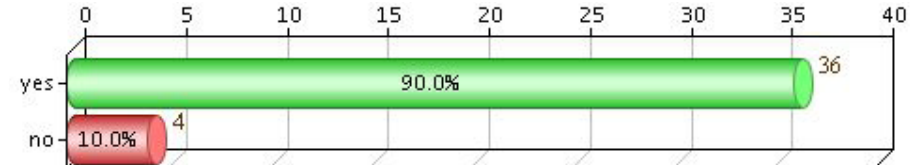
Figure 13 . Do you think the MOOC format is appropriate for your learning communities? ( N =